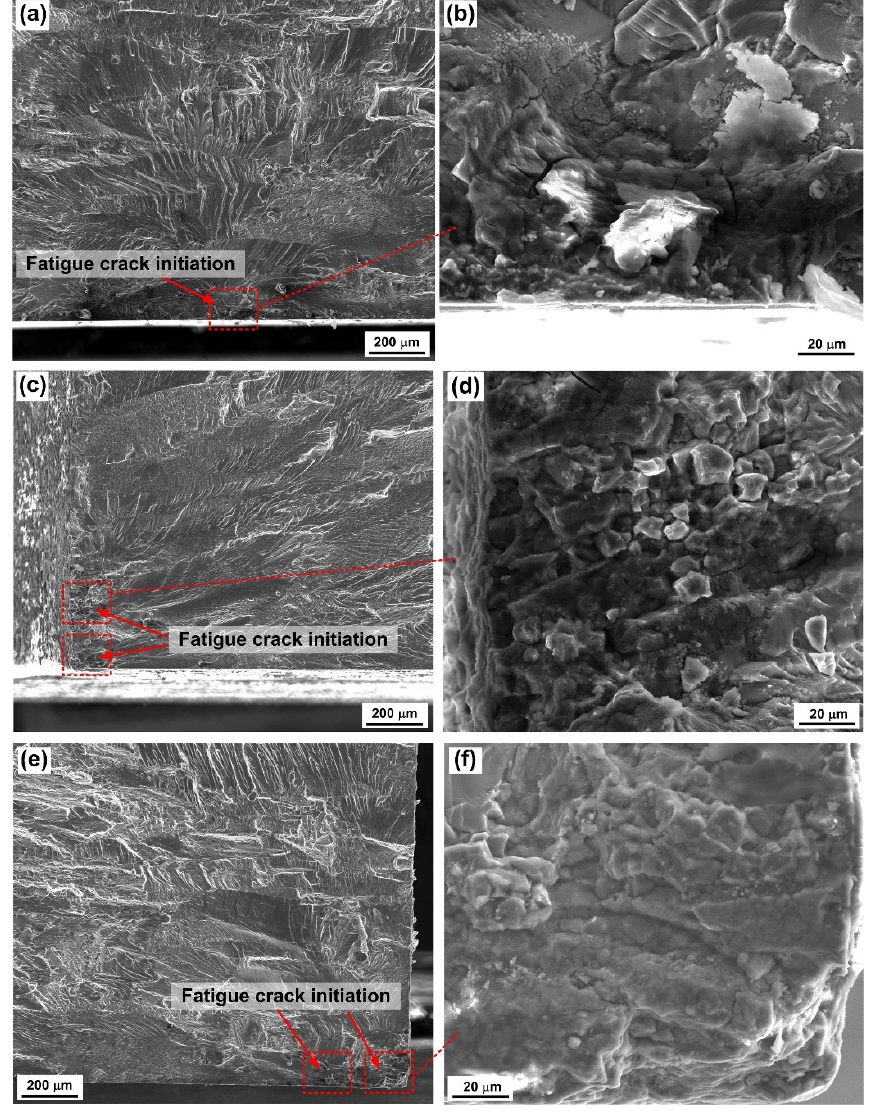
Figure 6. SEM images of the fatigue fractographies of the different 7085-T7452 aluminum alloy specimens: ( a , b ) uncorroded fatigue (UCF); ( c , d ) precorrosion + fatigue (PCF); ( e , f ) precorrosion + prefatigue + fatigue (PCPFF).